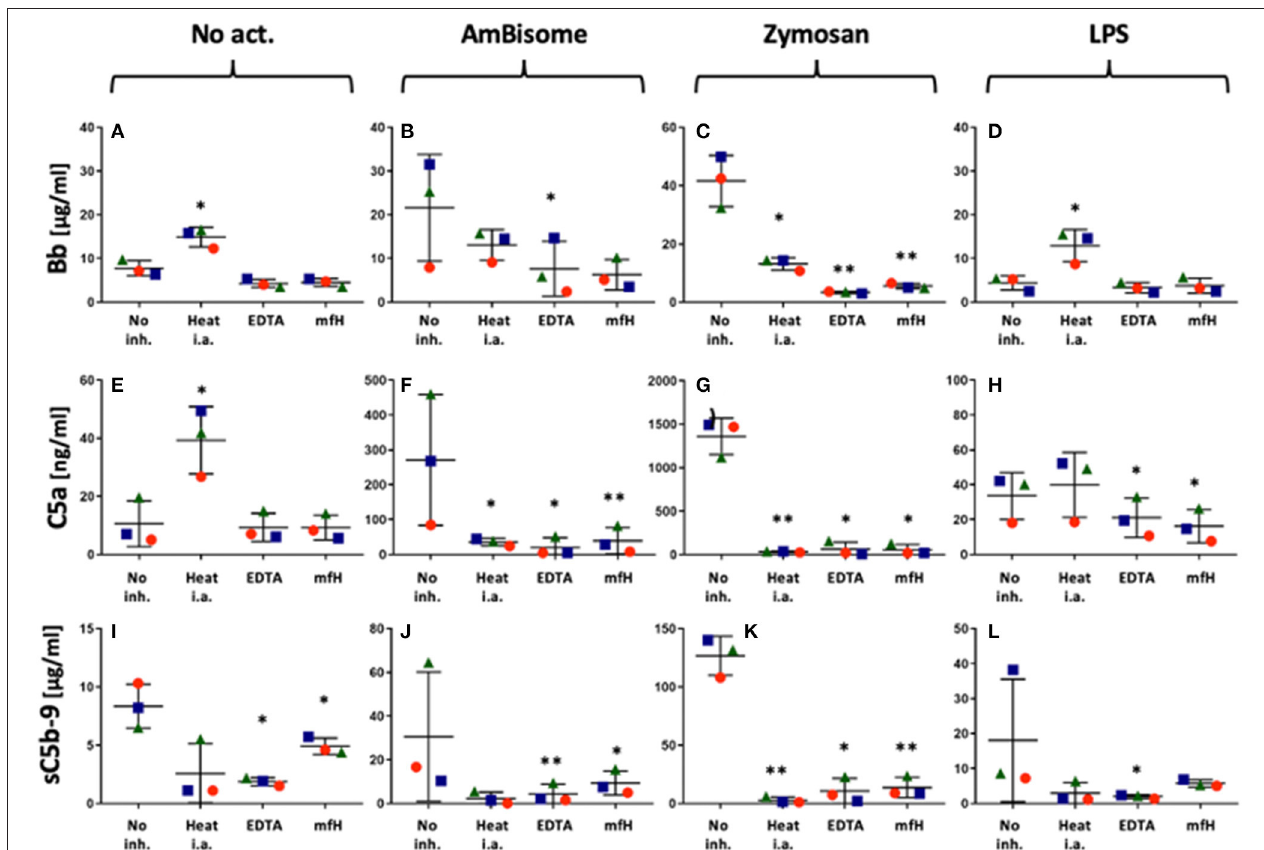
FIGURE 2 | Inhibition of AmBisome-, zymosan- and LPS-induced complement activation (ordered in columns) by different inhibition methods specified on the X axis. No act. and no inh. mean no added activator or complement inhibitor, respectively. On the X axes “Heat i.a.” “EDTA” and “mfH” mean heat-inactivation of autologous serum at 56 ◦ C for 30min, addition of 20mM EDTA or 1 µ M mfH, respectively. Different symbols specify the donors, the bars show the mean ± SD ( n = 3); *( P < 0.05) and ** ( P < 0.01) indicate statistically significant differences using one-tailed T -test comparing the values to the No Act. group.